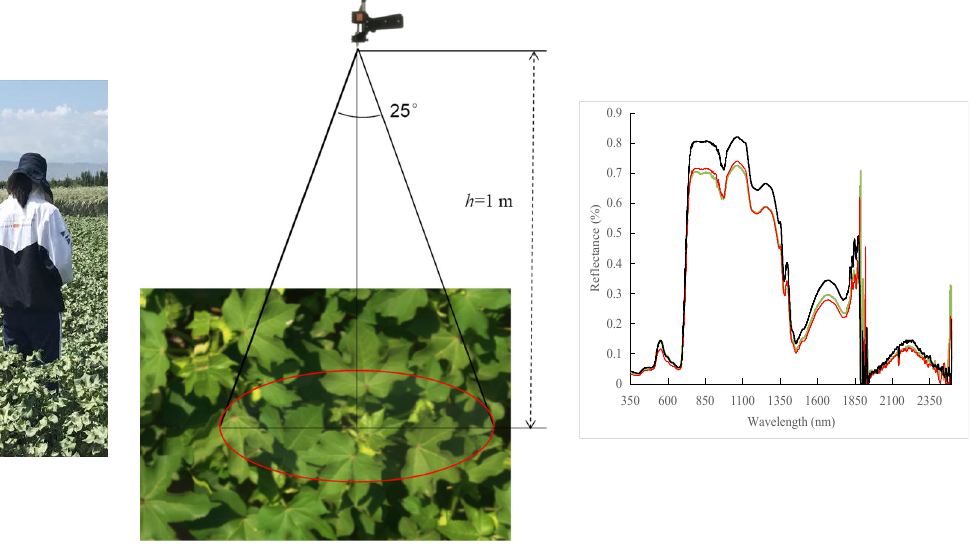
Figure 3. Acquisition of hyperspectral reflectance data of cotton canopy (2019 ‐ 45, 19 June).